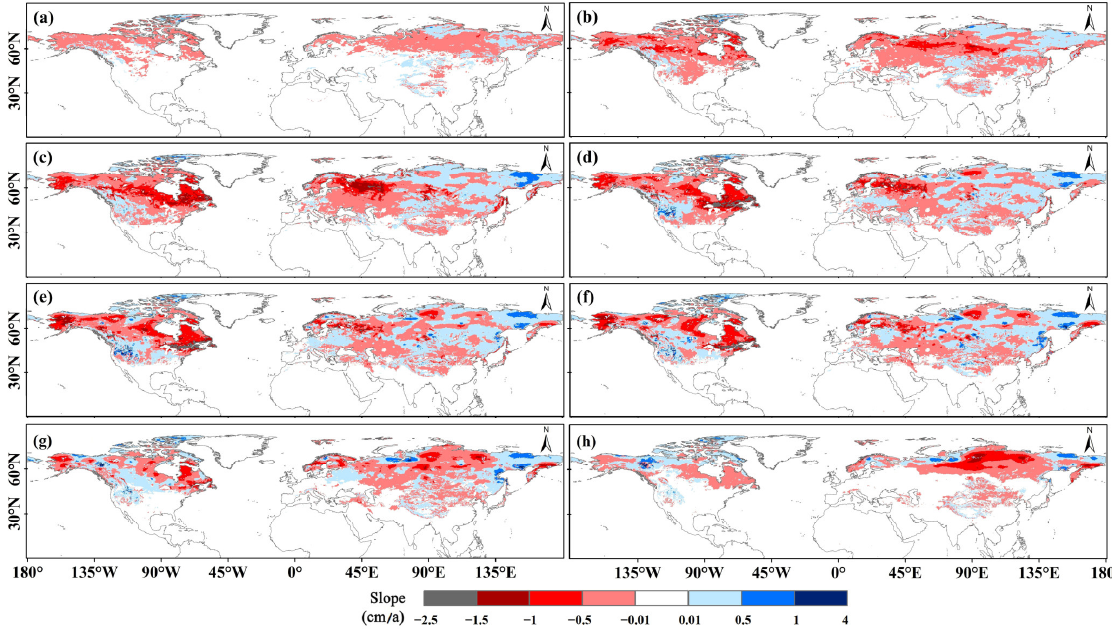
Figure 3. Variation slopes of the monthly average SD in the NH. ( a – h ) correspond to October, No-